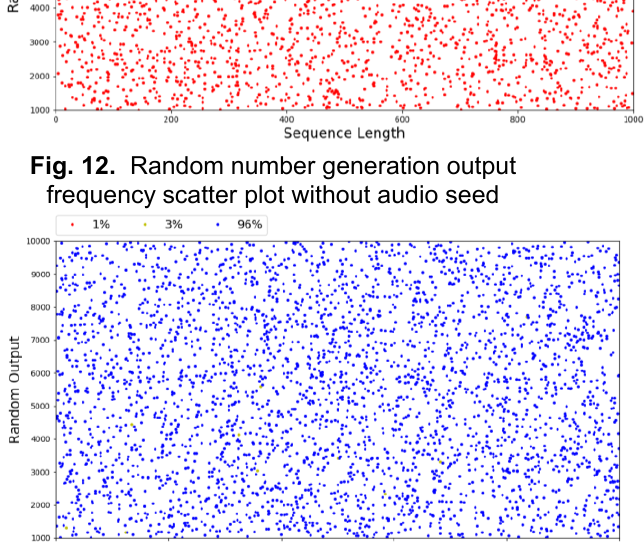
Fig. 16. Random number generation output frequency scatter plot with no-seed pre-optimisation high noise scenario